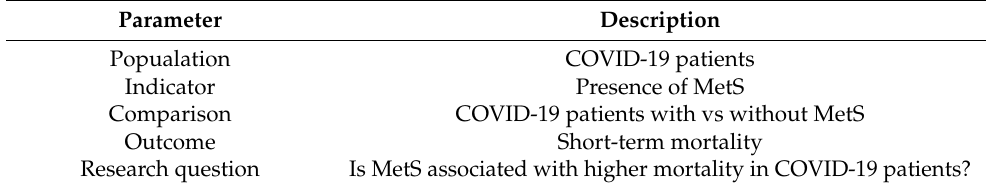
Table 1. PICO criteria description and research question defined to systematic